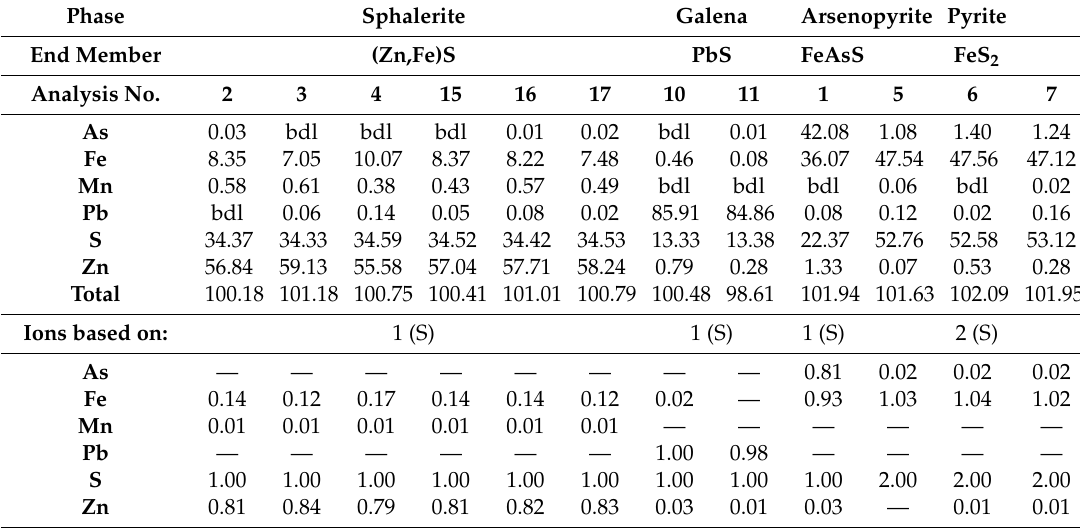
Figure 4. BSE image of free sphalerite grain with galena veins in Stratoni ZnS concentrate. Table 1. Electron probe micro-analyzer (EPMA) analyses of mineral phases present in Stratoni ZnS concentrate (bdl: below detection